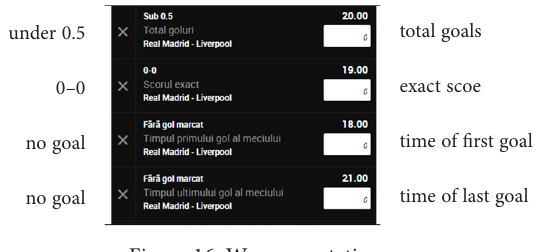
Figure 16. Wrong quotations (source: own processing based on the data available on UNIBET, 2019)